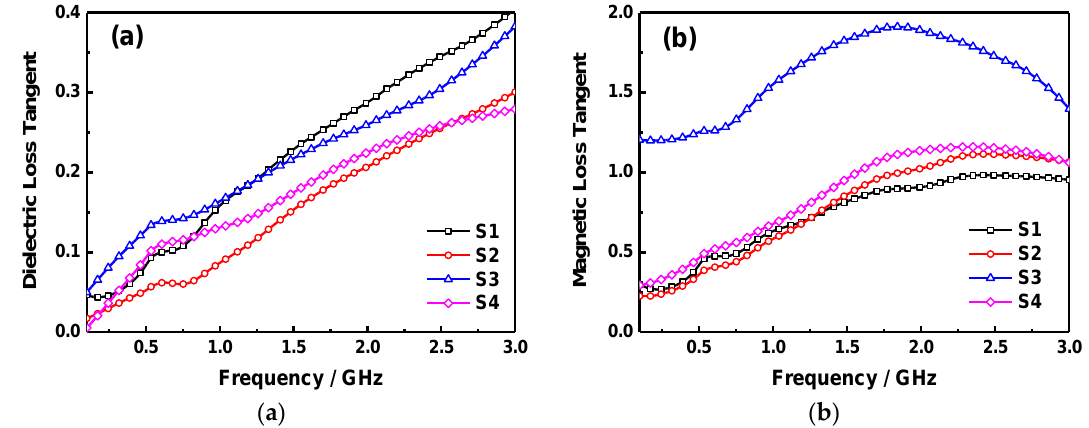
Figure 7. Frequency dependence of dielectric loss tangent ( a ) and magnetic loss tangent ( b ). Usually, the magnetic loss of ferrite mainly originates from hysteresis loss, eddy current